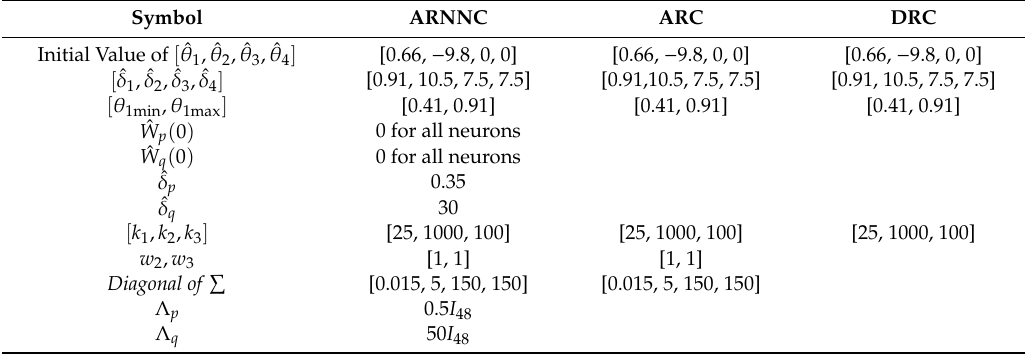
Table 2. Parameter setting of